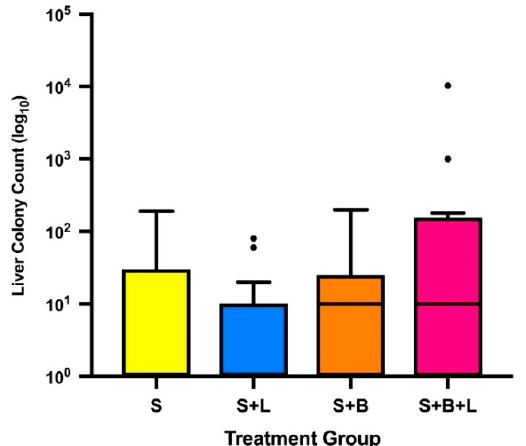
Figure 3. Liver metastatic colony counts by treatment group (median, IQR and range). Note that the median value of groups S and S + L is 0. • indicates outliers by Tukey’s method (>1.5 × IQR). Abbreviations: S, sevoflurane alone; S + L, sevoflurane and lidocaine; S + B, sevoflurane and bosutinib; S + B + L, sevoflurane, lidocaine and bosutinib.